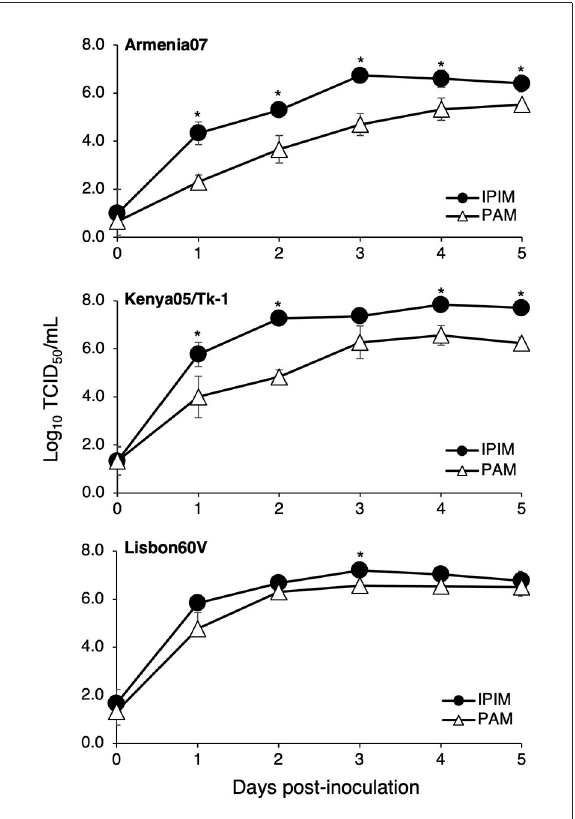
FIGURE6 Comparison of the ASFV production in IPIM and PAM. Cell cultures were infected with Armina07 ( upper ), Kenya05/Tk-1 ( middle) , and Lisbon60V isolates ( lower ) (MOI = 0.01). The culture supernatant samples were collected at the indicated timepoints. Viral production in the IPIM ( closed circle ) and PAM ( open triangle ) cell cultures were estimated by titration experiments with the IPIM. Data represent the mean and standard deviations of three experiments. Asterisks indicate statistically significant differences in the viral production between the IPIM and PAM cell cultures ( * p <